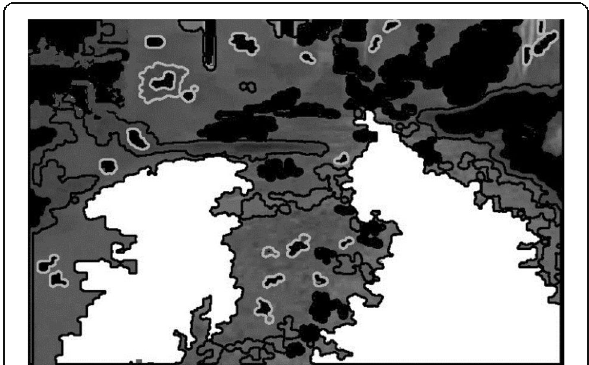
Fig. 5 SVM classification result